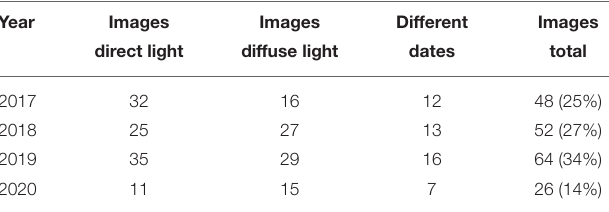
TABLE 1 | Eschikon wheat segmentation (EWS) dataset overview of the distribution of direct and diffuse light with respect to the number of different